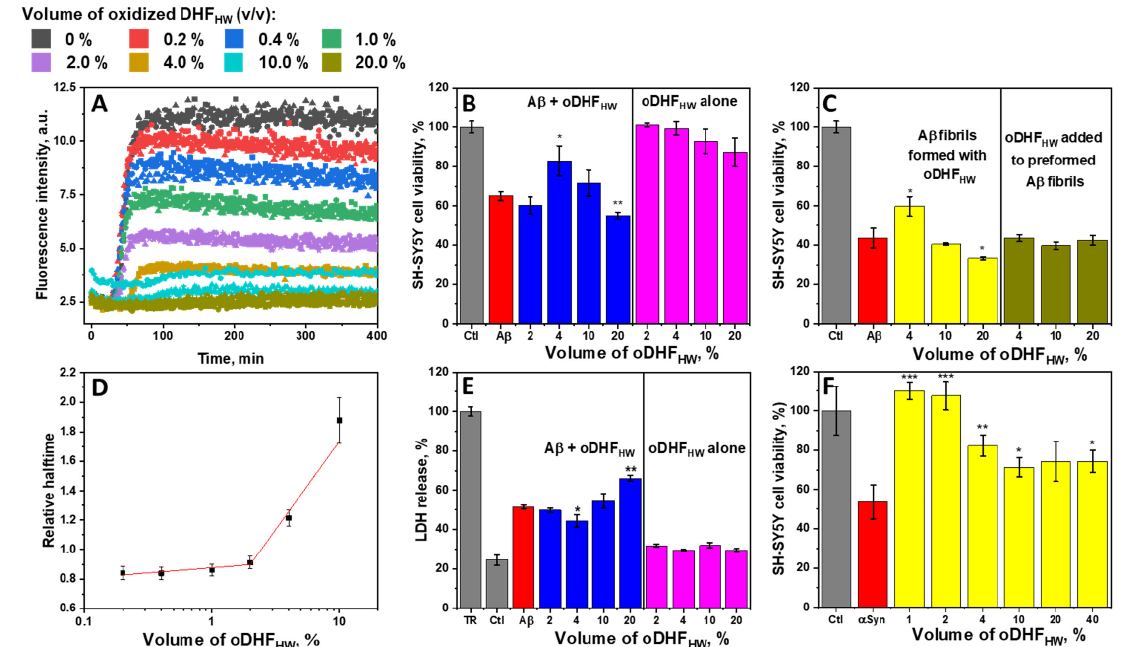
Figure 2. The kinetic curves of 1 µ M A β aggregation with a range of oDHF HW (0%–20% v / v ) ( A ), and their respective relative halftime values ( D ) compared to the control sample. SH-SY5Y cell viability ( B ) and LDH release ( E ) after incubating (48 and 24 h, respectively) with 3 µ M of A β and different oDHF HW concentrations (% by v / v ). SH-SY5Y cell viability after incubating 48 h with 3 µ M A β ( C ) and 100 µ M aSyn ( F ) fibrils formed with or without the oDHF HW . Student’s t-test significance values were compared to the A β or aSyn controls, * p < 0.05, ** p < 0.01, and *** p < 0.001. Relative aggregation halftime error bars are one standard deviation (n = 3) approximated using a linear fit.